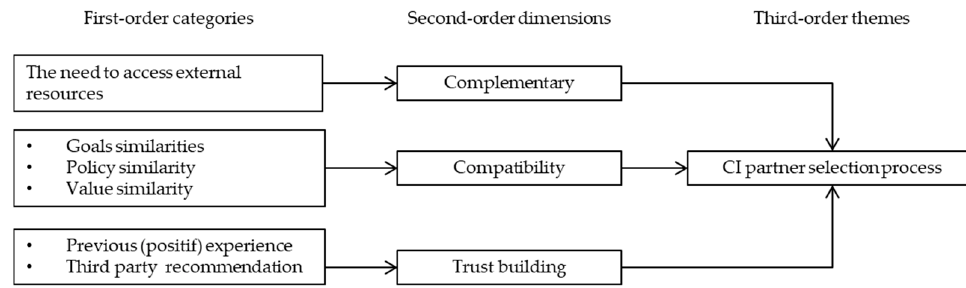
Figure 1. Data structure with first-order, second-order, and third-order. Resources: Research data process.